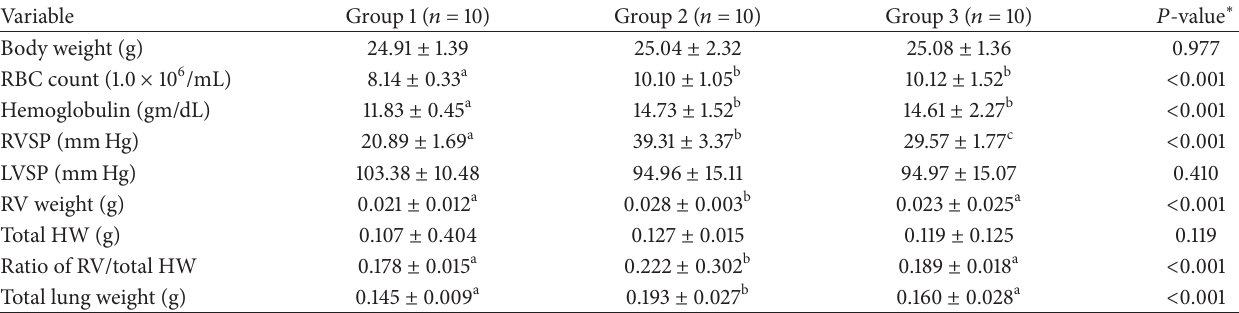
Table 2: Baseline characteristics of three group animals at day 28 after hypoxia-induced pulmonary arterial